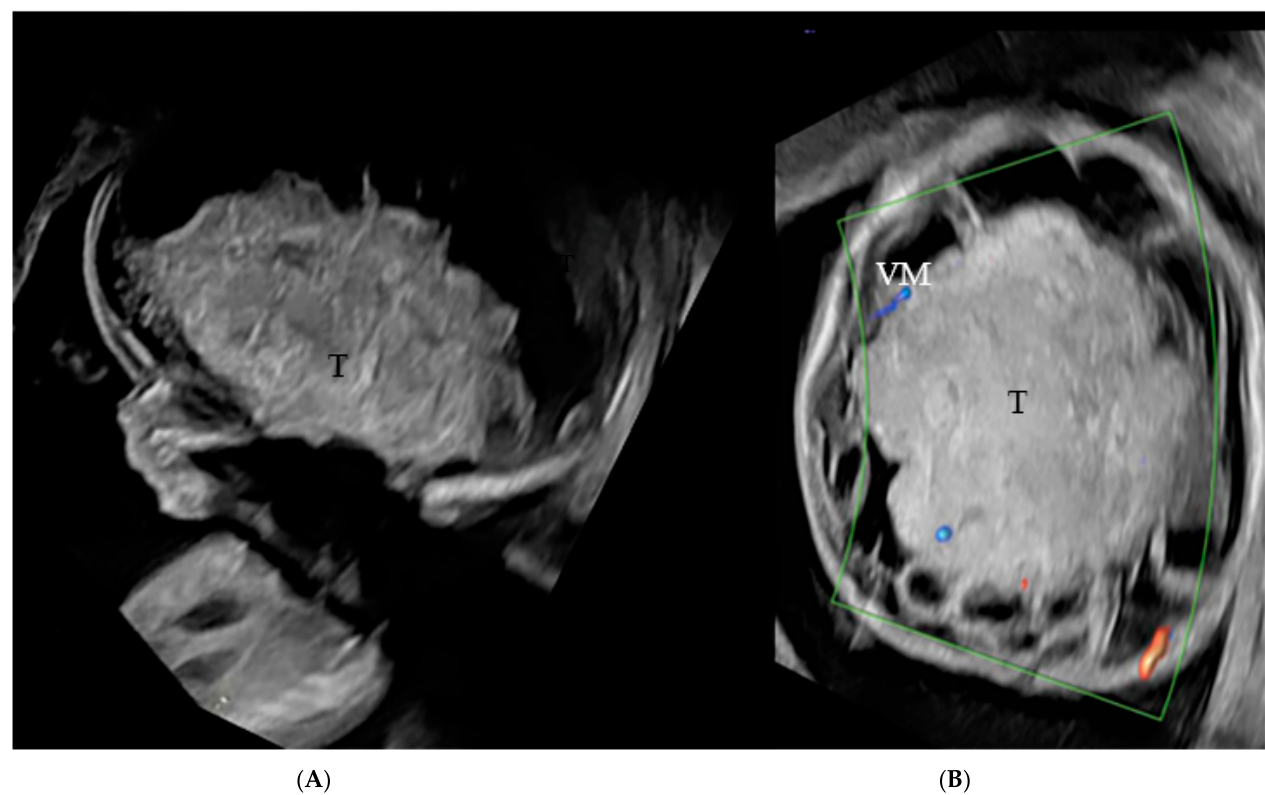
Figure 2. ( A , B ): US showing a 5 × 6.3 × 7 cm predominantly hyperechogenic solid midline mass lesion, centered in the suprasellar region (T). High grade supratentorial ventriculomegaly (VM) is noted.